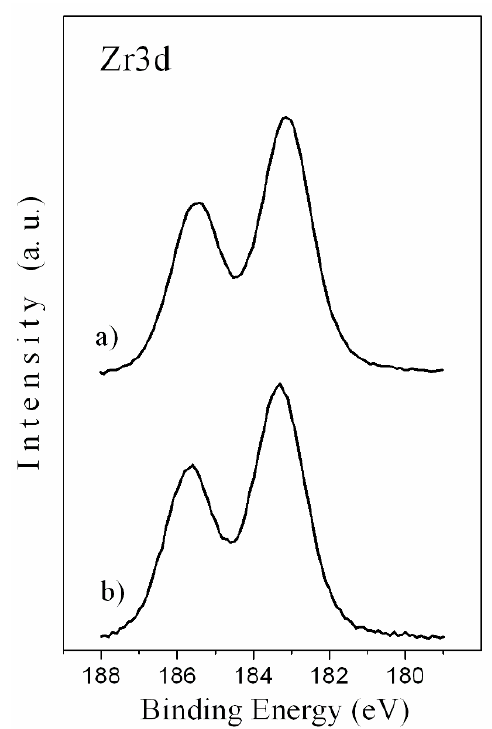
Figure 6. Binding energy of O1s peaks of: a) ZrMo O (OH) •2H O; 2 7 2 2